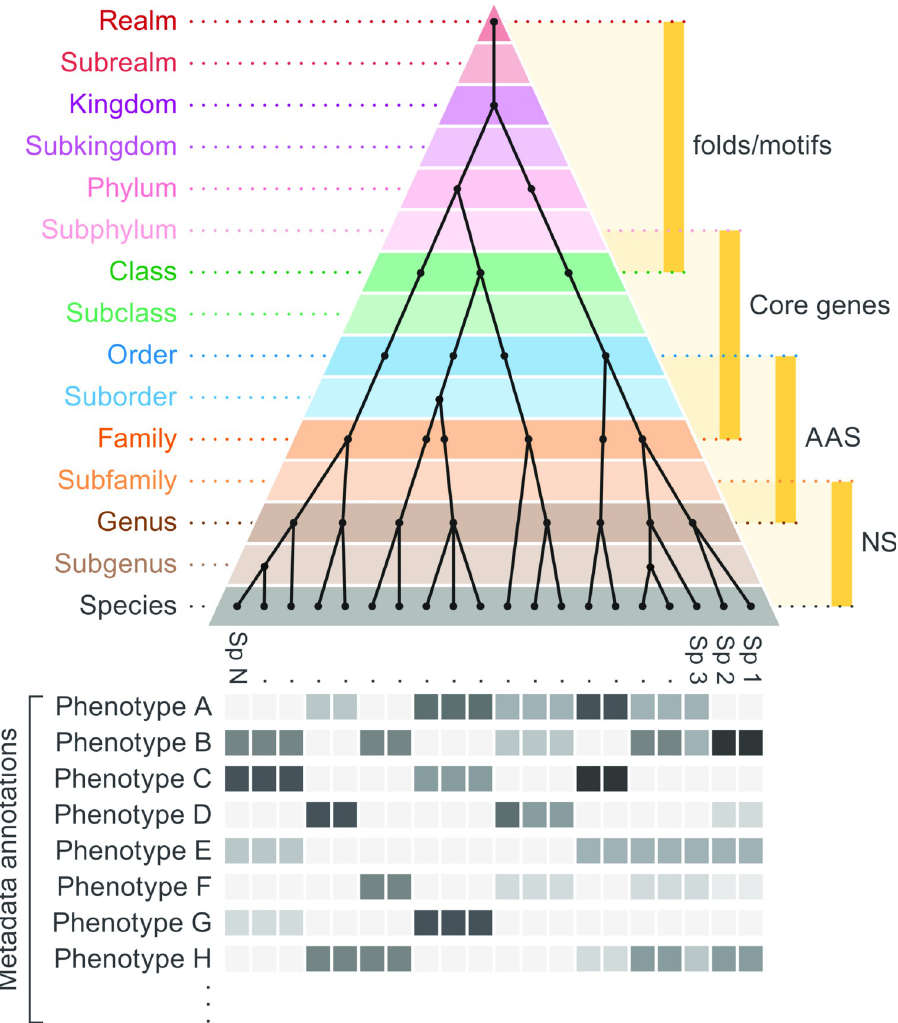
Fig 1. Ranks used in virus taxonomy. Schematic depiction of the 15-rank taxonomic framework used by the ICTV. It includes the methodologies that may be used to determine virus evolutionary relationships and make assignments at each rank. The pyramid shape indicates that the number of taxa increases from the top rank (realm) to the most basal rank (species, Sp.). The names of the 15 ranks are shown on the left of the pyramid, and the methodologies are on the right (AAS, amino acid sequence similarity; NS, nucleotide sequence similarity). The pyramid includes a hypothetical example of the taxonomy of a realm, indicating the number of taxa at each rank (filled circles). The phenotypic properties of classified viruses that may inform rank placements are depicted below the